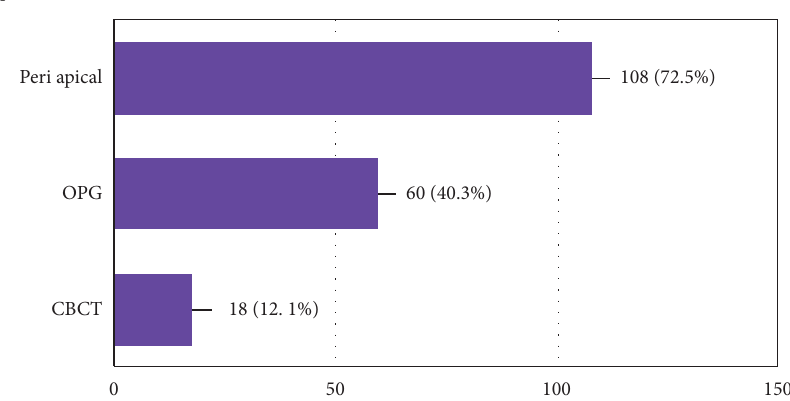
Figure 3: What is the type of X-ray imaging you think is the most appropriate before dental extraction?